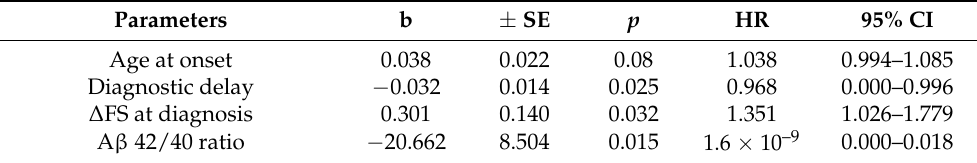
Table 6. Multivariate Cox regression analysis for overall survival for ALS patients. Significative variables believed to be significant at the univariate analysis were considered for multivariate analysis. Parameters b ± SE